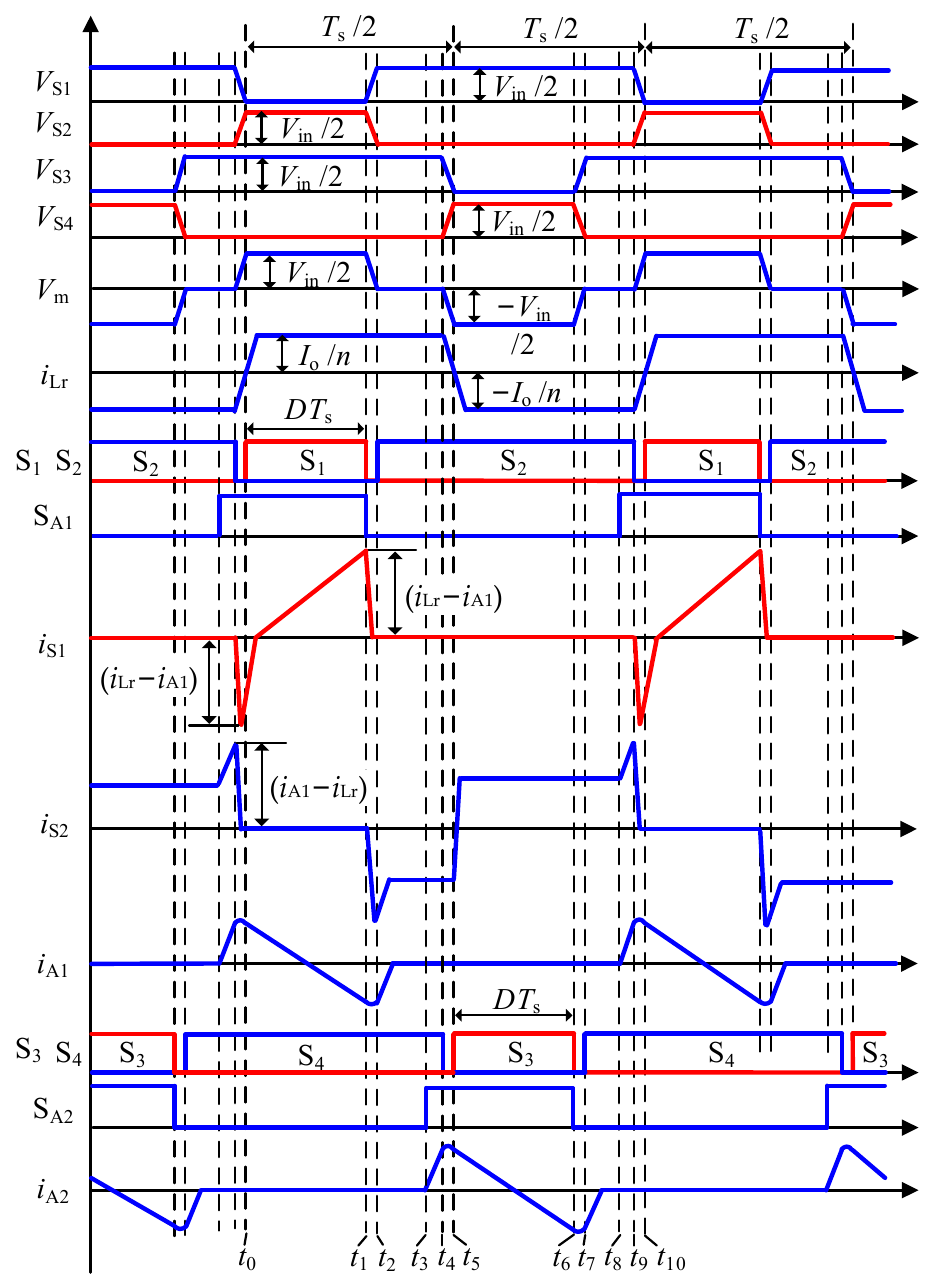
Figure 4. Theoretical waveforms of the ITLDC with proposed ACACs. Interval 7 (Figure 5g, t 6 ~ t 7 ): At t 6 , the main switch S 3 and the auxiliary switch S A2 are turned off simultaneously and S A2 is turned off at zero ‐ voltage condition. The current i A2